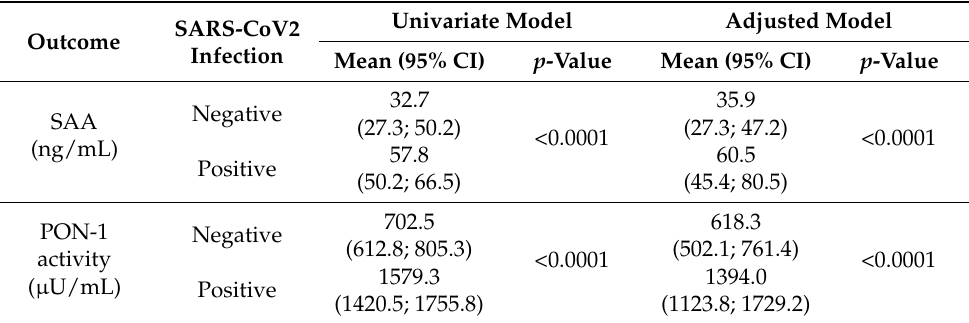
Table 2. Differences in SAA levels and in PON-1 activity by SARS-CoV2 positivity.